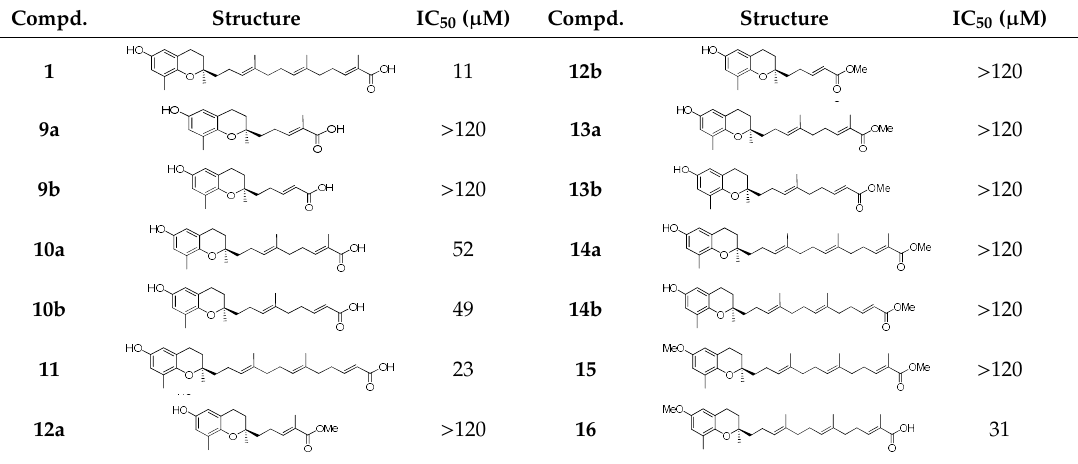
Table 2. IC 50 values of garcinoic acid ( 1 ) and its analogs in inhibiting hpol β .